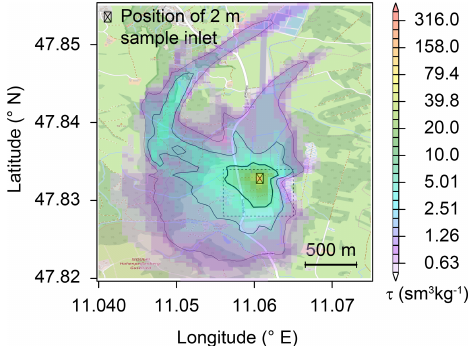
Figure 7. The average footprint area as calculated by the FLEXPART-COSMO model. The model was driven with local wind vectors and observed N 2 O flux rates and indicates a major contri- bution of soils south-west of the ambient air inlet. The source sen- sitivities tau ( τ ) are given as the product of residence time (in sec- onds) and inverse atmospheric density (in m 3 kg − 1 ). Isolines en- close the areas of largest source sensitivities summing up to 15%, 30%, and 45% (decreasing thickness of lines) of the total simulated source sensitivity. The dashed rectangle indicates the area depicted in Fig. 1. Individual source signatures for the 12 events are